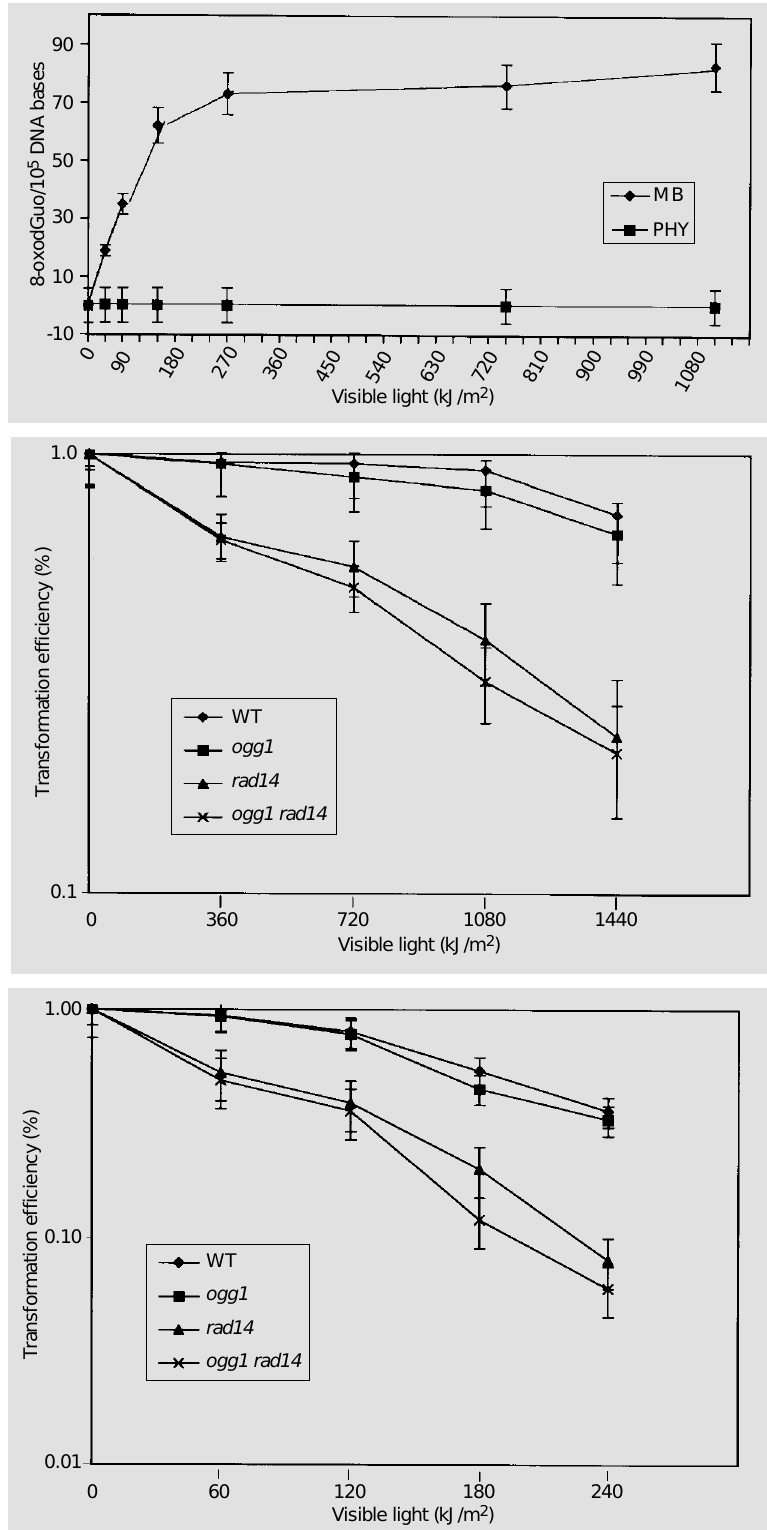
Figure 2 - Detection of 8-oxodGuo in DNA treated with phycocyanin (PHY) or methylene blue (MB) plus visible light. Salmon sperm DNA was first treated with PHY or MB plus visible light and then with Fpg protein (50 µg/